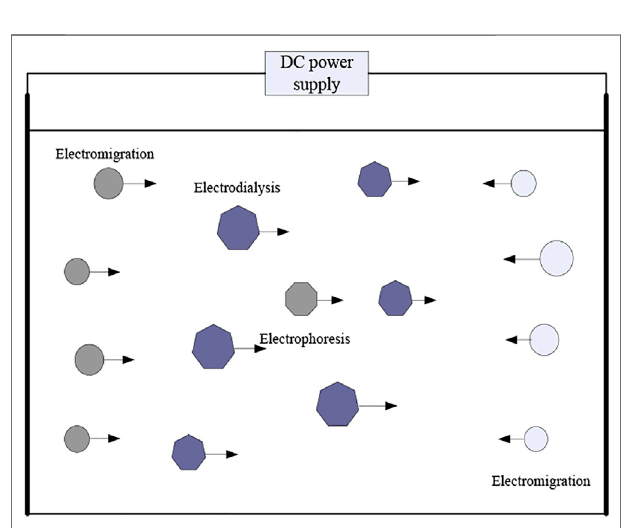
FIGURE 4 | Schematic diagram of electric power